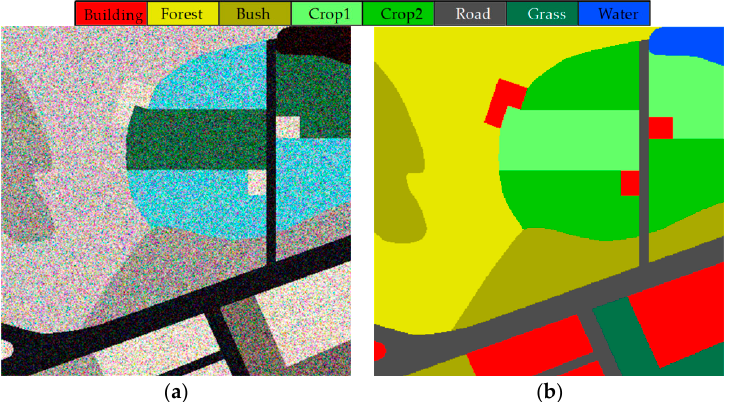
Figure 1. Simulated single-look polarimetric synthetic aperture radar (PolSAR) data as the first data set: ( a ) Pauli RGB image and ( b ) the object spatial distribution reference map of the simulated image.